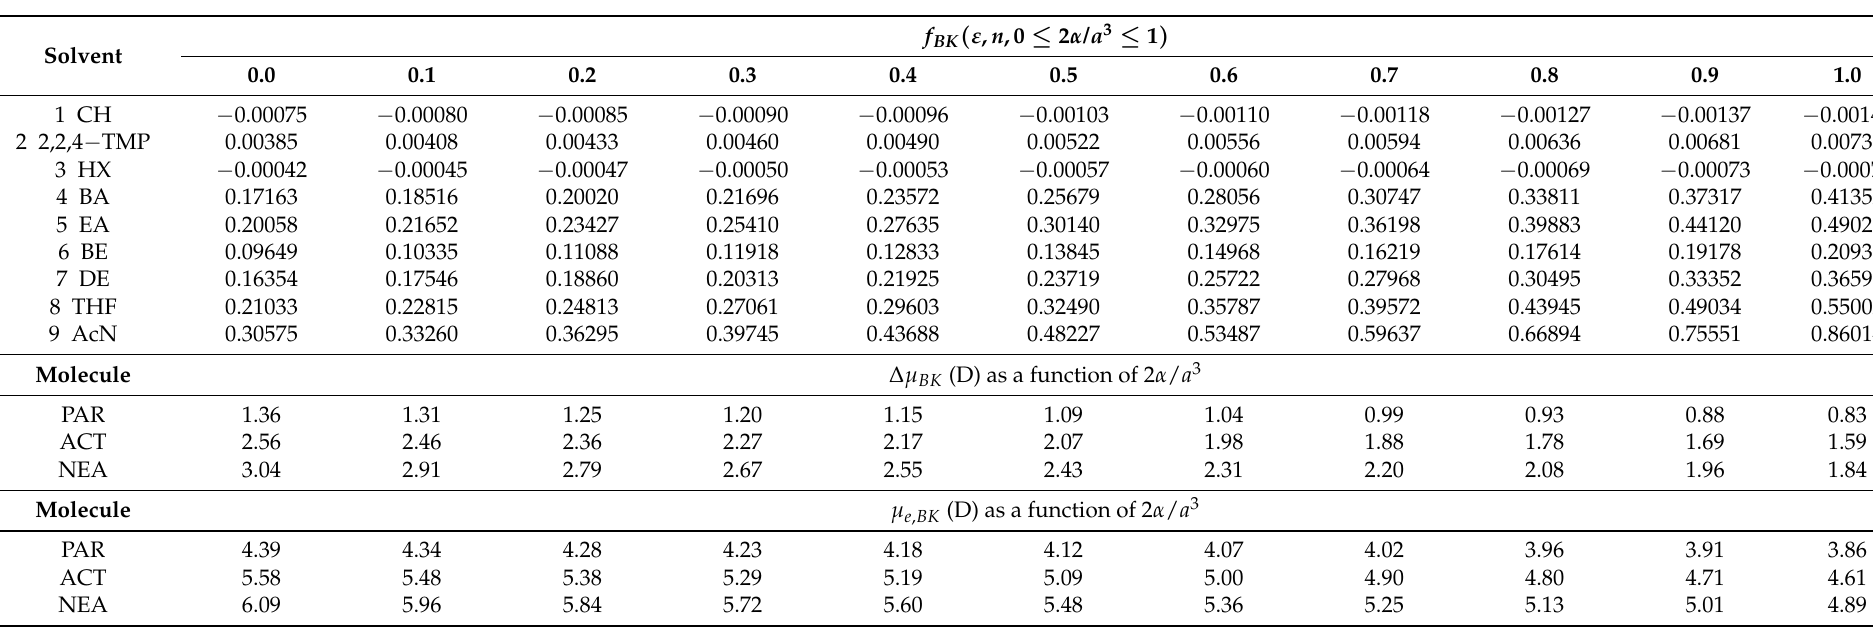
Table 3. Polarizability-dependent polarity function f BK ( ε , n ,0 ≤ 2 α / a 3 ≤ 1 ) , values of ∆ µ BK (D) and µ e , BK (D) for PAR, ACT, and NEA as a function of 2 α / a 3